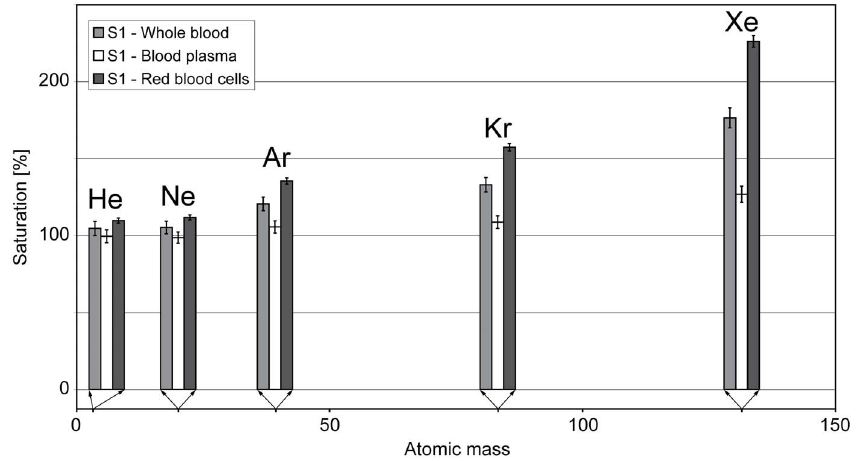
Figure 3. Percentage saturation of human blood plasma (white), red blood cells (black) and whole blood (gray) with noble gases relative to air-saturated water (at a temperature of 36.5 u C and a salinity of 9 g/kg at an altitude of 225 m a.s.l.) measured in the sample from subject S1. For red blood cells, the saturation increases with the atomic mass of the noble gas.